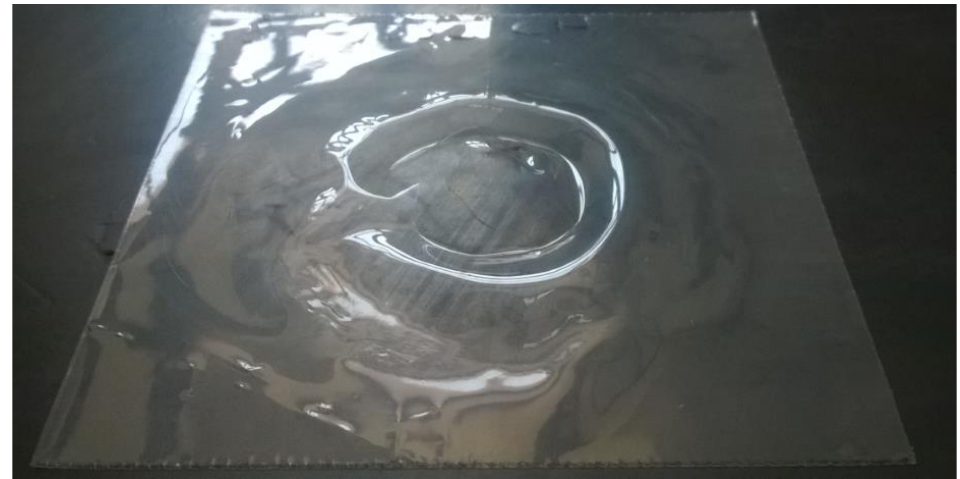
Figure 10. Specimen ETFE after the impact test at Energy = 0.38 J.